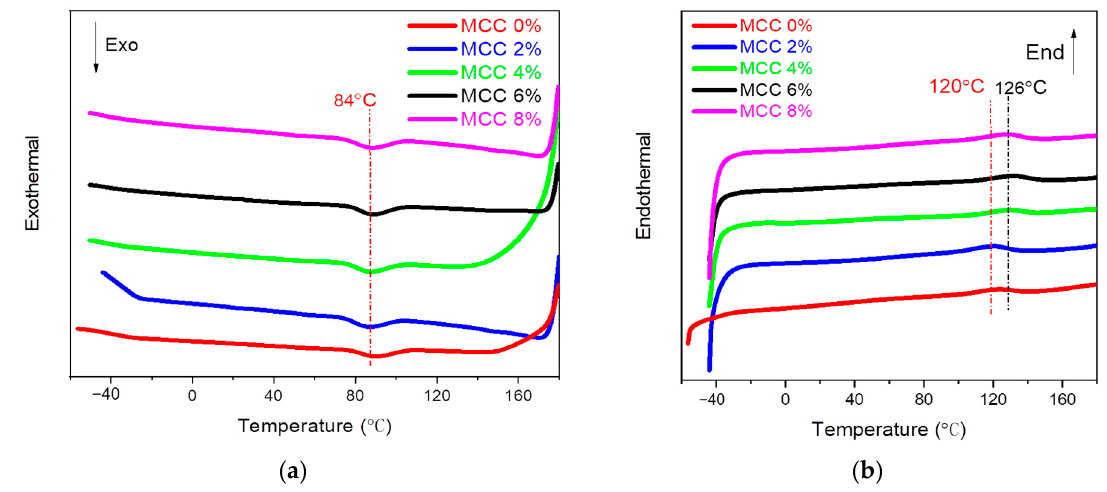
Figure 6. The DSC curves of samples, ( a ) the cooling round and the second heating round ( b ). Table 4. Thermal behaviors of the PBAT/TPS/MCC